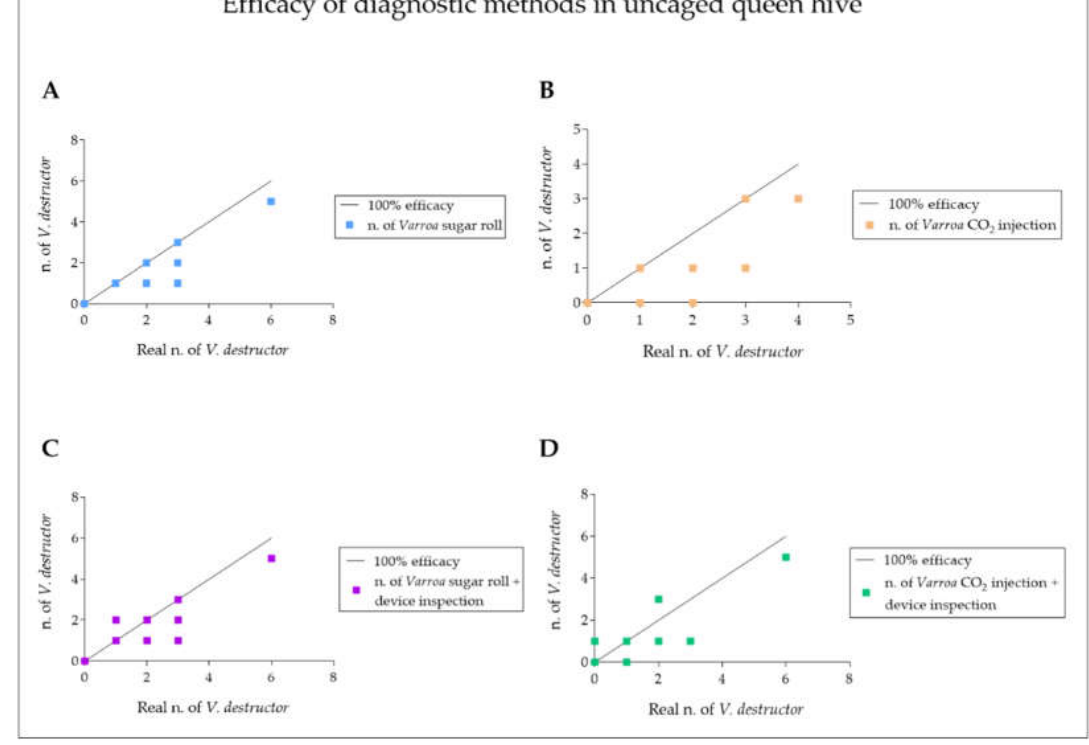
Figure 3. The panel reports the degree of efficacy of the diagnostic methods used to analyze uncaged queen hive samples of Apis mellifera ligustica . The graphs show the number of V. destructor counted with sugar roll test ( A ), CO 2 injection ( B ), sugar roll test and device inspection ( C ) and CO 2 injection and device inspection ( D ), as a function of their real number in bee samples ( V. destructor collected via the tested method added to those collected after washing the sample). Each point represents a measurement. The points on the black line represent an efficiency of the measurement method of 100%.